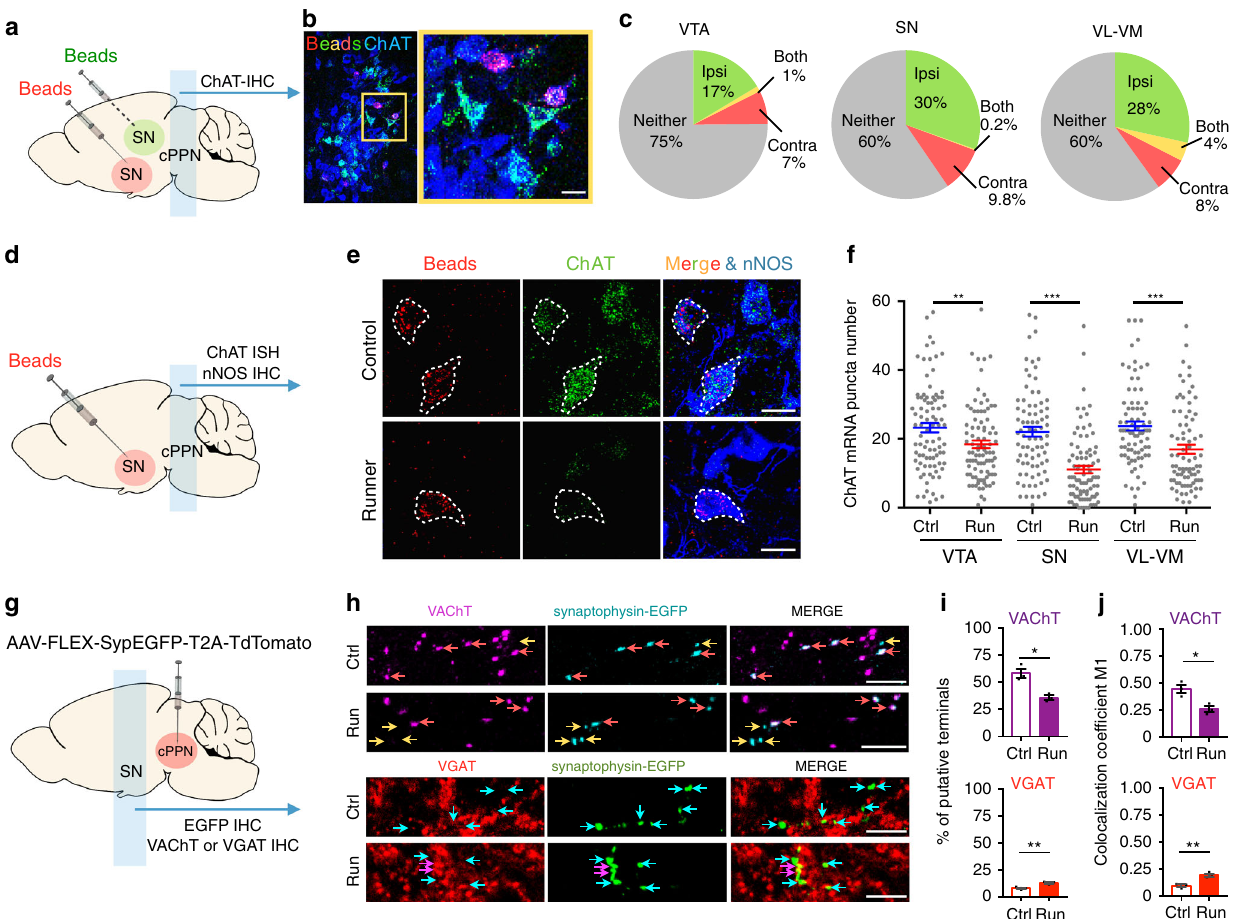
Fig. 5 Running reduces the number of ChAT transcripts in a subset of cholinergic cPPN neurons that project to the VTA, SN and VL-VM. a Experimental design to validate cholinergic innervation of target nuclei by the cPPN. Red or green retrobeads (beads) were injected bilaterally into target nuclei with one color per side. Substantia nigra (SN) provides an example. b Triple labeling of retrobeads and ChAT in a coronal section of cPPN in a mouse injected with retrobeads. Scale bar, 50 μ m. c Summary of the percentage of cholinergic neurons (ChAT + ) that project to corresponding nuclei. Ipsi, ipsilaterally. Contra, contralaterally. Both, both ipsi- and contralaterally. Neither, no retrobeads. n = 3 animals examined per region. n = 829 cells for the VTA, 806 cells for the SN, and 812 for the VL-VM. d Experimental design to identify the target(s) of neurons with decreased numbers of ChAT transcripts. SN is shown as an example. e Triple-labeling of retrobeads, ChAT mRNA transcripts, and nNOS proteins in both control and runner cPPNs. Scale bar, 20 μ m. f Y -axis is the mean number of ChAT fl uorescent puncta in single nNOS + cells. Each dot represents one neuron. n = 4 animals per group. n = 89 cells for VTA-Ctrl, 91 for VTA-Run, 81 for SN-Ctrl, 87 for SN-Run, 82 for VL-VM- Ctrl, 80 for VL-VM-Run. g Experimental design to identify presynaptic changes in transporter expression of cholinergic cPPN axons in the SN. AAV8-phSyn1-FLEX-tdTomato-T2A-Syptophysin-EGFP-WPRE (AAV-FLEX- SypEGFP-T2A-TdTomato) was injected into the cPPN of ChAT-Cre mice. Coronal sections containing the SN were immunostained for EGFP and VAChT or EGFP and VGAT. h Double immunostaining of VAChT and EGFP or VGAT and EGFP in the SN of non-runner controls or 1-week runners injected with AAV- FLEX-SypEGFP-T2A-TdTomato. Scale bar, 10 μ m. i Percentage of VAChT + or VGAT + terminals in putatively cholinergic terminals in the SN. j The coef fi cient M1 of antibody colocalization with putative cholinergic presynaptic terminals. n = 10139 EGFP + terminals for VAChT-Ctrl, 9629 for VAChT- Run, 10174 for VGAT-Ctrl and 10611 for VGAT-Run. For each group, data were quanti fi ed from 12 z-stack images from three animals. Statistical signi fi